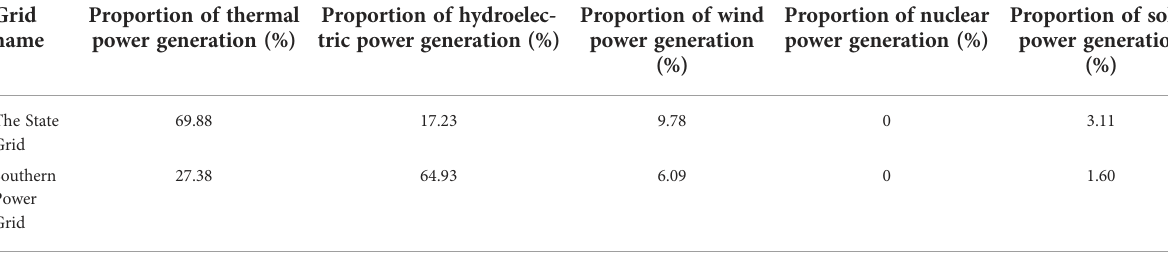
TABLE 3 Grid power energy